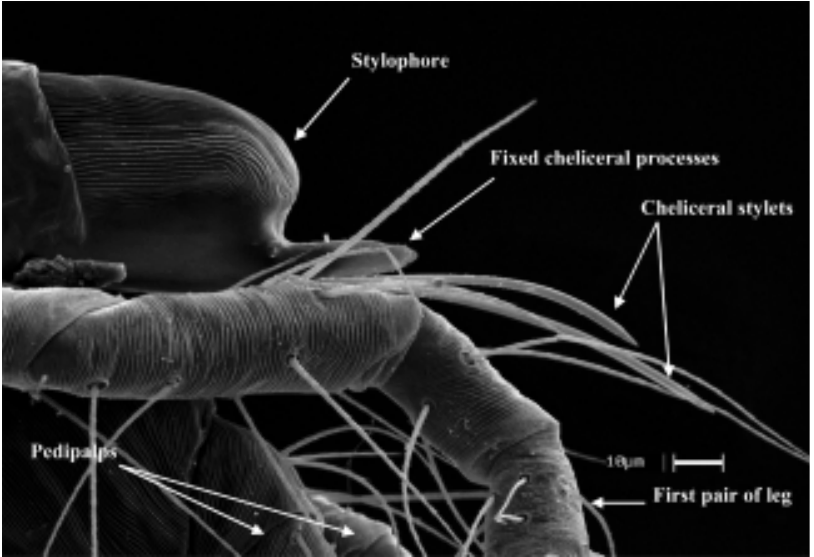
Fig. 1. Lateral view of the gnath- osoma of Tetranychus urticae